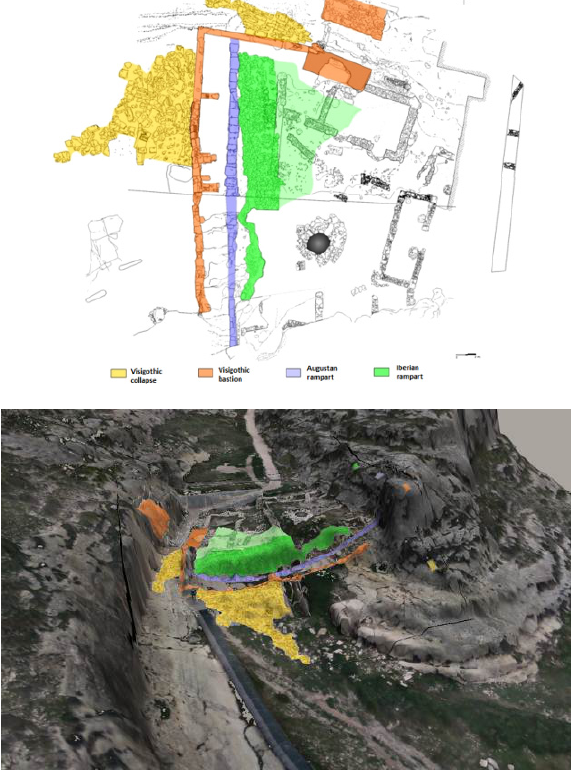
Figure 10. Archaeological sketch (up) overlapped with the 3D model